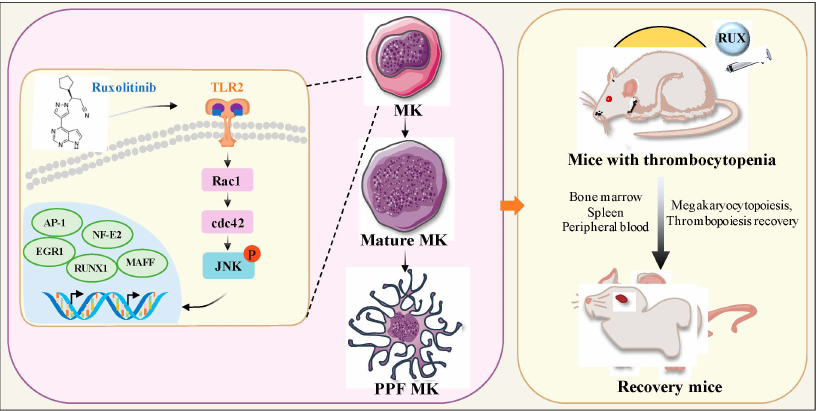
Figure 10. Schematic illustration of the role of ruxolitinib in MK differentiation and platelet pro‑duction. Ruxolitinib induces the expression of various cytokines and TLR2, activates the Rac1/cdc42/JNK signaling pathway, and leads to the expression of AP‑1, EGR1, RUNX1, and NF‑E2. As a result, the activation of AP‑1, EGR1, RUNX1, NF‑E2 promote the expression of genes related to MK differentiation and thrombopoiesis. These genes contribute to MK maturation and platelet for‑ mation and promote the recovery of bone marrow and spleen MKs and accelerate platelet production in RI‑mice. PPF: proplatelet‑forming